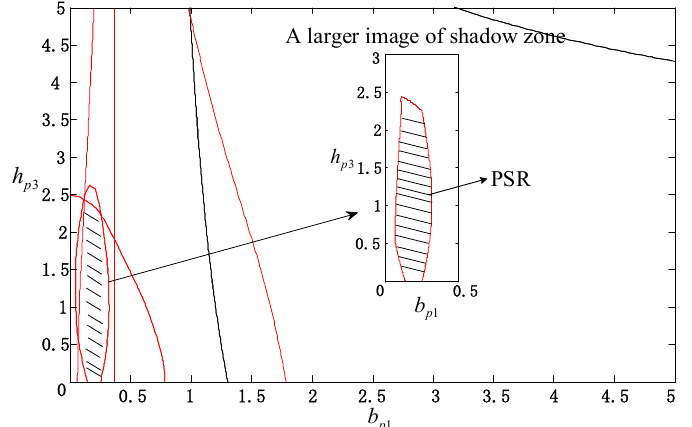
Figure 3. The parameter stability region (PSR) of h p3 -b p1 (parameter equilibrium point: h p3 = 1.1, b p1 = 0.2).